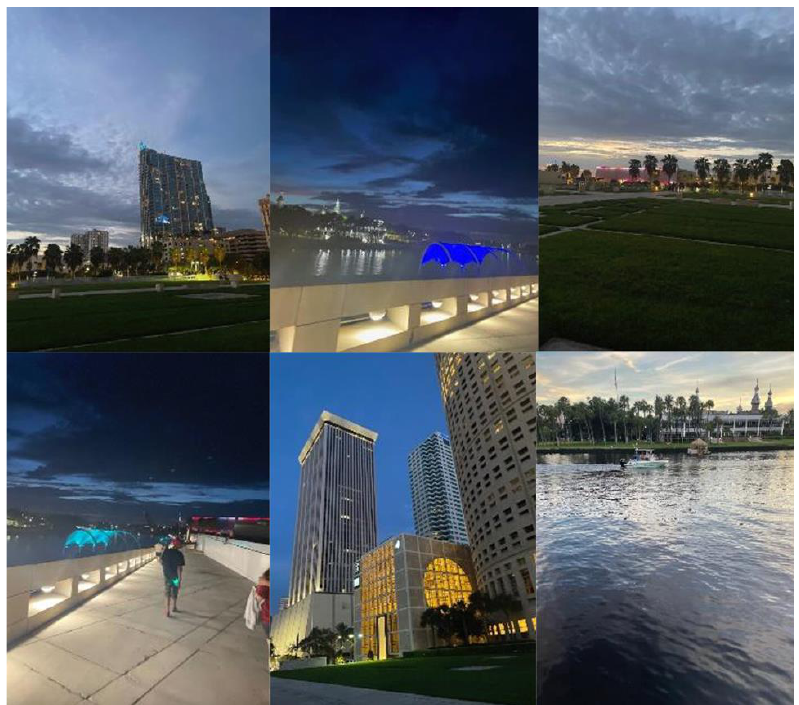
Figure 13. A rundown building with colored hearts representing optimism in the face of challenges.